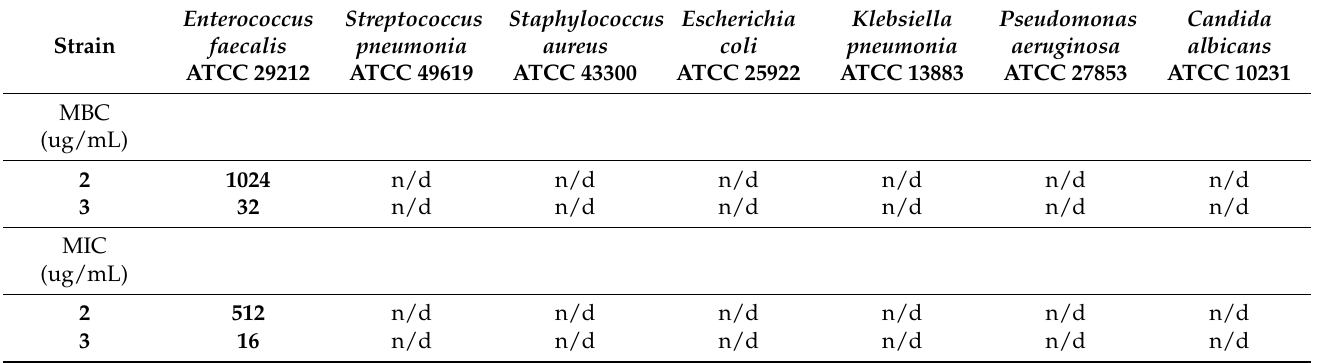
Table 2. In vitro antibacterial activity of compounds 2 and 3 expressed as a minimal inhibitory concentration (MIC) (ug/mL) and minimal bactericidal concentration